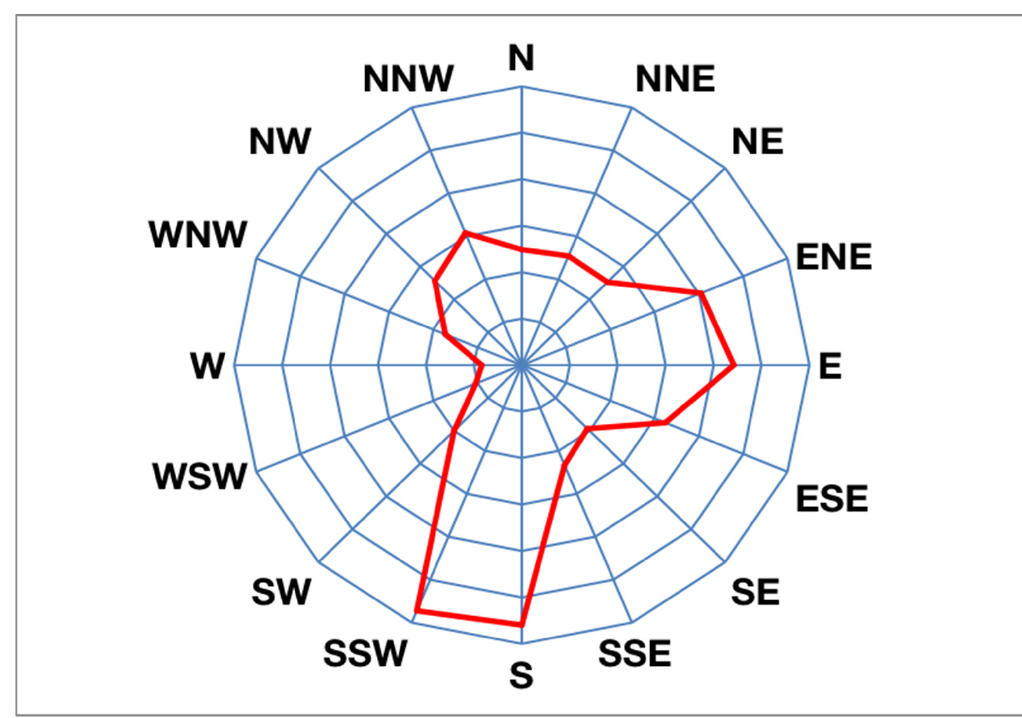
Figure 2. Winter wind rose illustration of Deqing City.